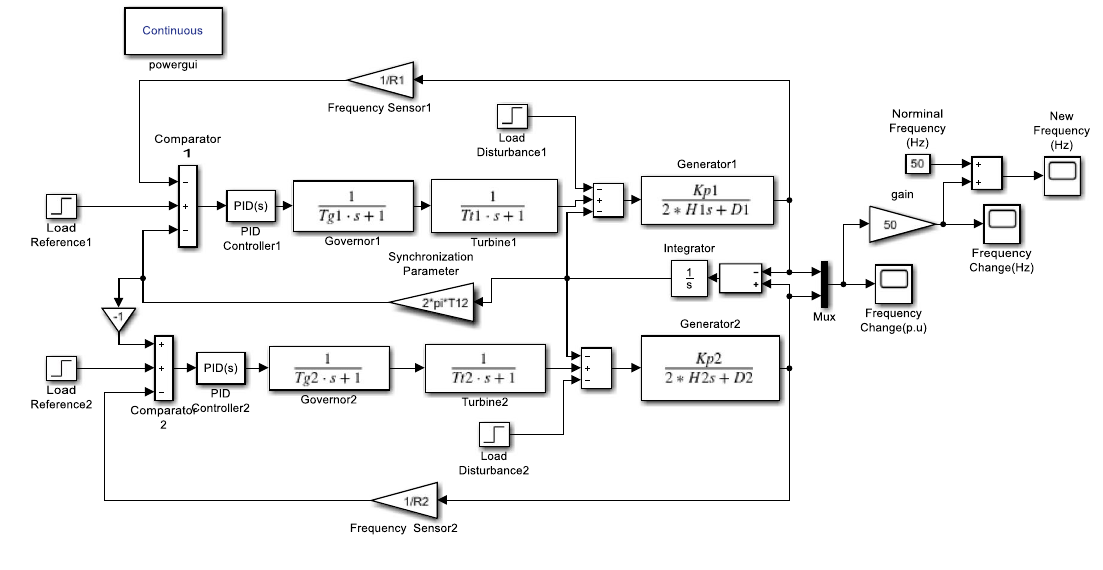
Fig. 3 Existing Two-area power system PID controllers in Rwanda